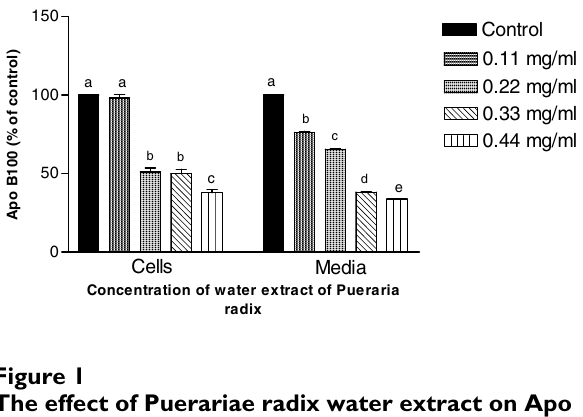
The effect of water extract of Puerariae radix on intracellular total, free and esterified cholesterol concentrations in HepG2 cells. Hep G2 cells were incu- bated with water extract of Puerariae radix for 24 h. Total, free and esterified cholesterol levels were quantified by GLC and expressed as a percentage of control ± SEM (n = 3). Means were compared using one-way analysis of variance (ANOVA) followed by Tukey's post-hoc test. Different let- ters in graphs indicate significance from each other at p < 0.05. NS: not significant at p >